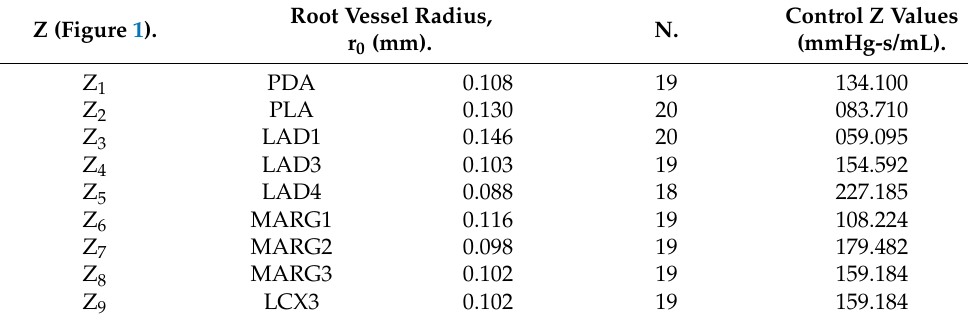
Table 2. Parameters used to compute microvascular impedances. Z (Figure